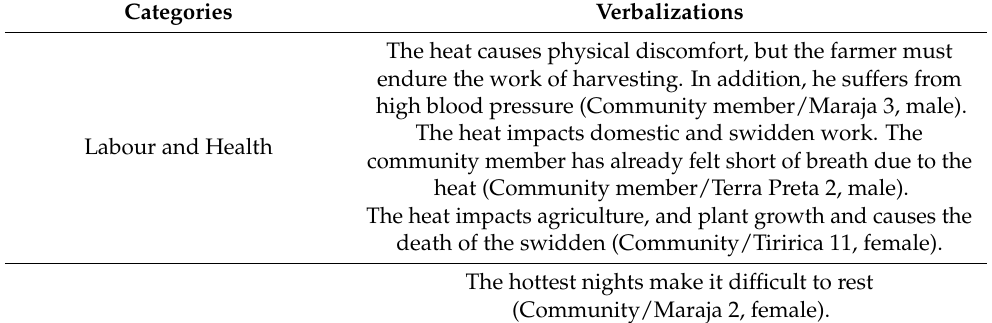
Table 3. Impacts of “quentura” (extreme air temperature).